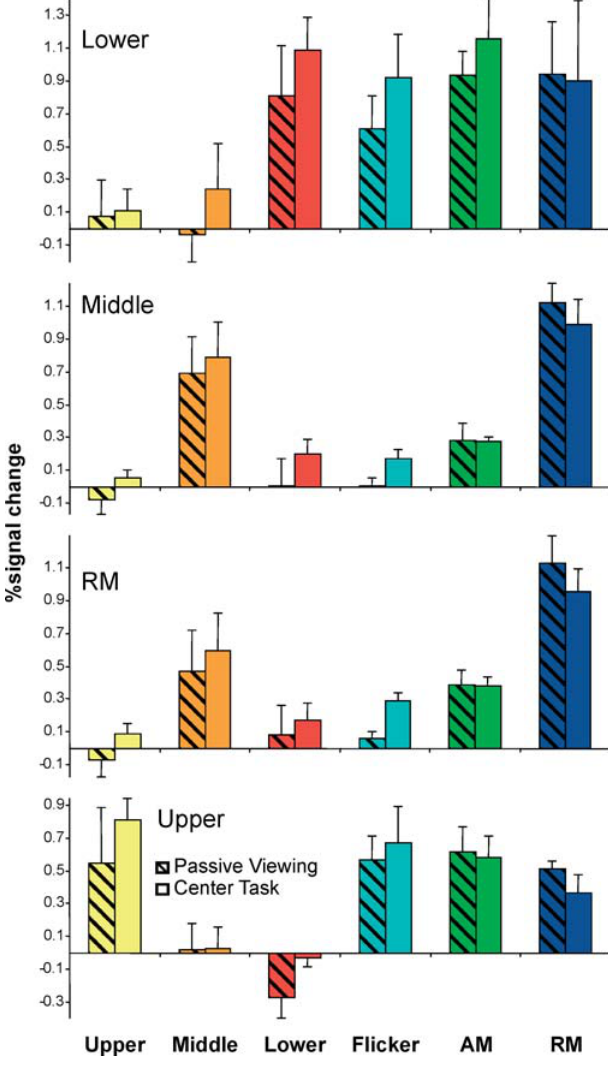
Figure 4. Response Profile for Different ROIs in V1 for Experiment 2 The four panels correspond to four ROIs that were defined in V1 by the respective conditions. To determine the ROIs for the three mapping conditions—upper, middle, and lower—the relevant condition was contrasted with the remaining two mapping conditions in a conjunction analysis (e.g., upper . lower and upper . middle). For the real-motion ROI, the real-motion condition was contrasted with the upper and lower mapping conditions (conjunction analysis). The bars designate percent- age signal change of the peak response relative to baseline for the different conditions (see Materials and Methods). The hatched bars are activations from runs with passive viewing only, and the solid bars are from runs with center task. For both the real-motion and middle ROI, the response to the apparent-motion stimulus is significantly larger than the response to the flicker squares. This is not the case for the upper and lower ROIs. Error bars correspond to standard errors of the mean. DOI: